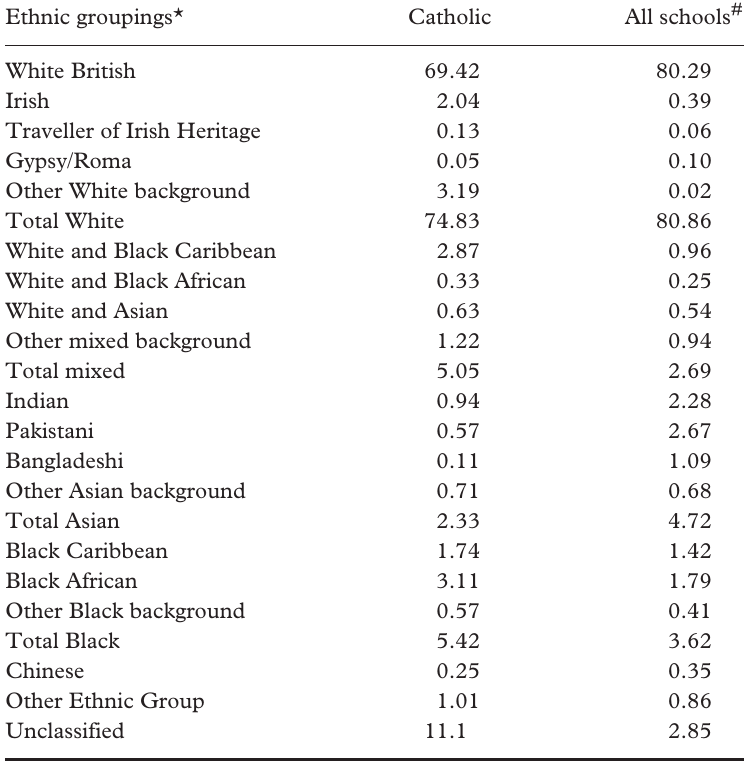
Table 2. Percentage of pupils of compulsory school age in England 2003–2004 by